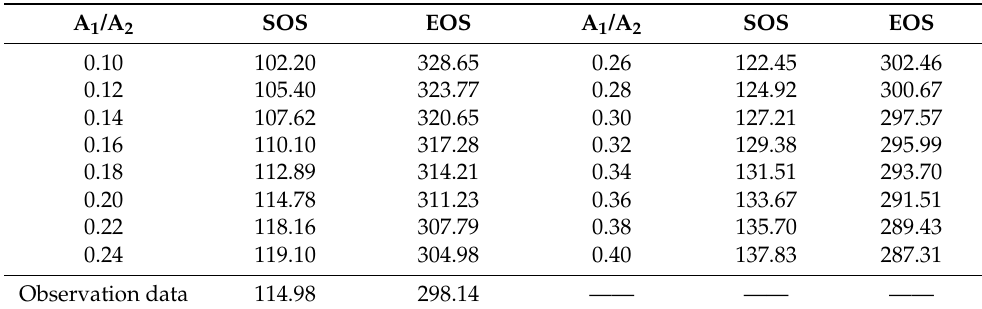
Table 1. Phenology (i.e., SOS and EOS) extracted from different thresholds (A 1 /A 2 ) and ground-based monitoring data in